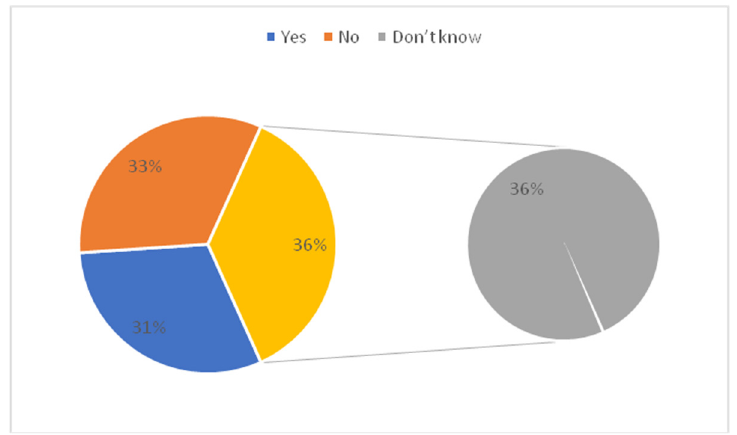
Figure 3. Parent’s attitude about vaccination being more dangerous for children than adults.